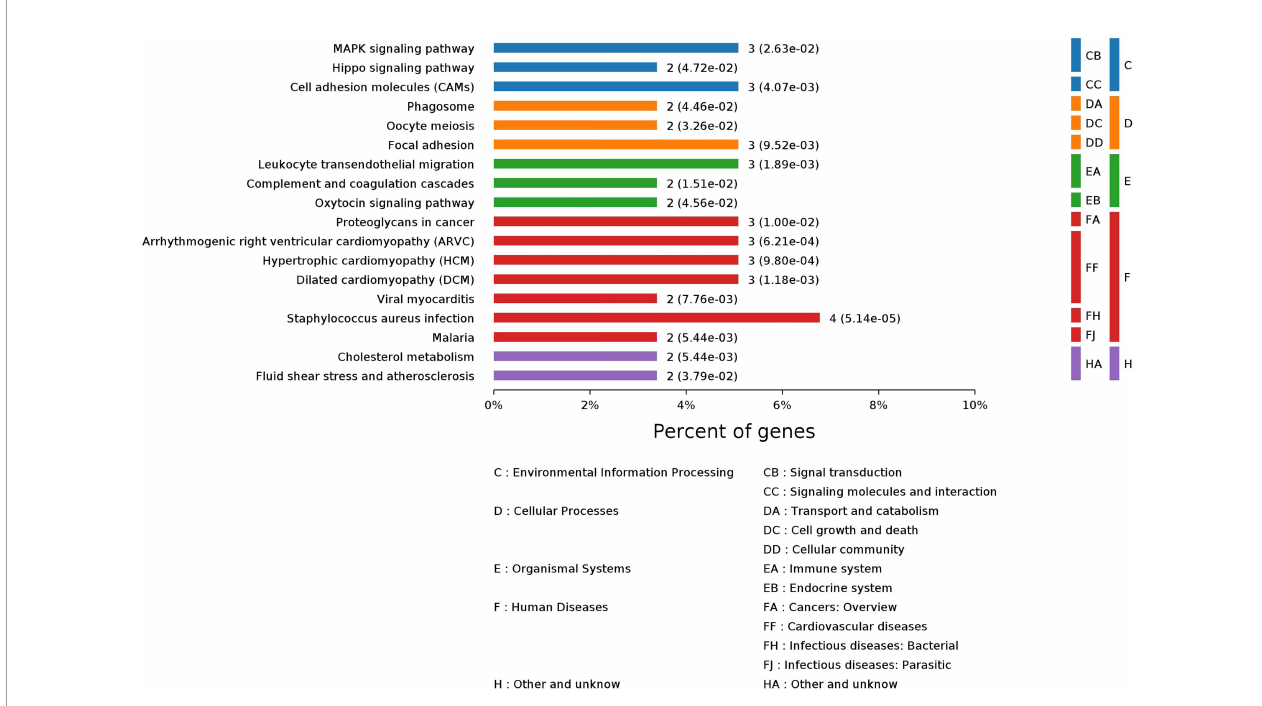
FIGURE 2 | Pathway enrichment analysis of 64 signi fi cantly changed proteins in 20 CRC patients after